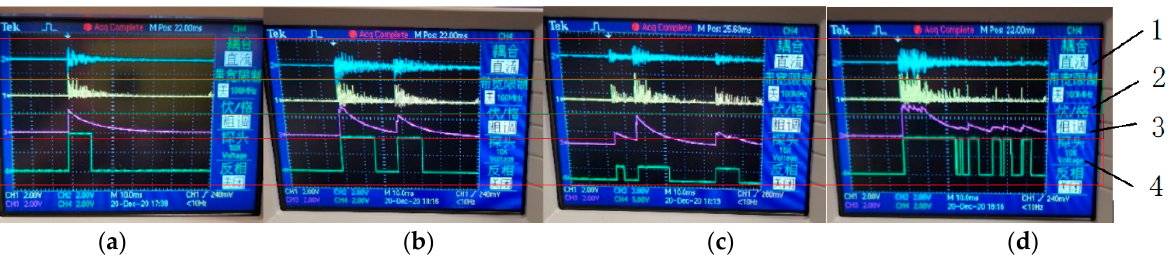
Table 2. Recognition accuracy rate.